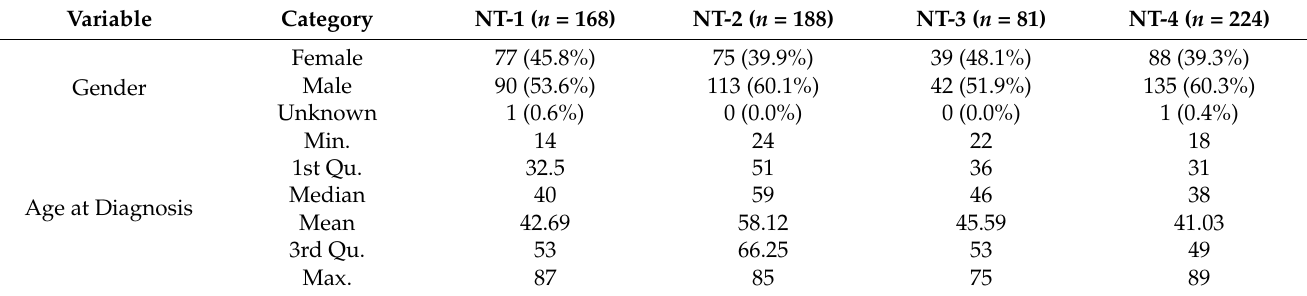
Table 1. Age at diagnosis and gender for NT-1-4 gliomas.